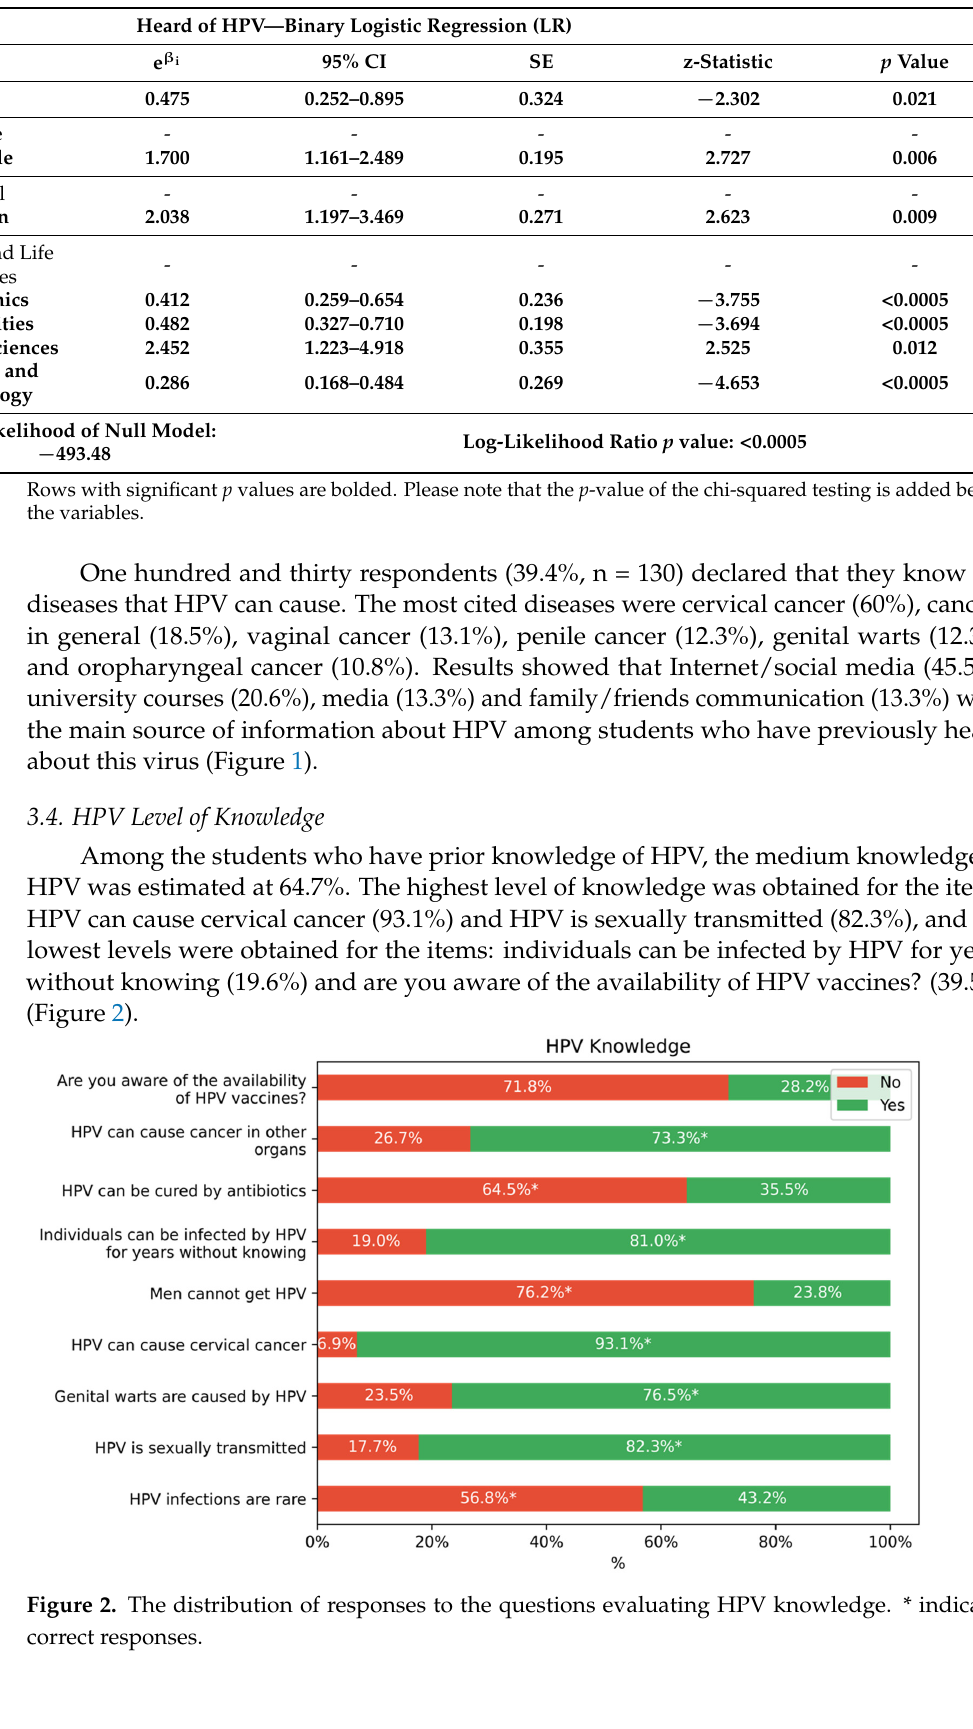
Table 3. Logistic regression model outlining determinants predicting having heard of HPV previously.